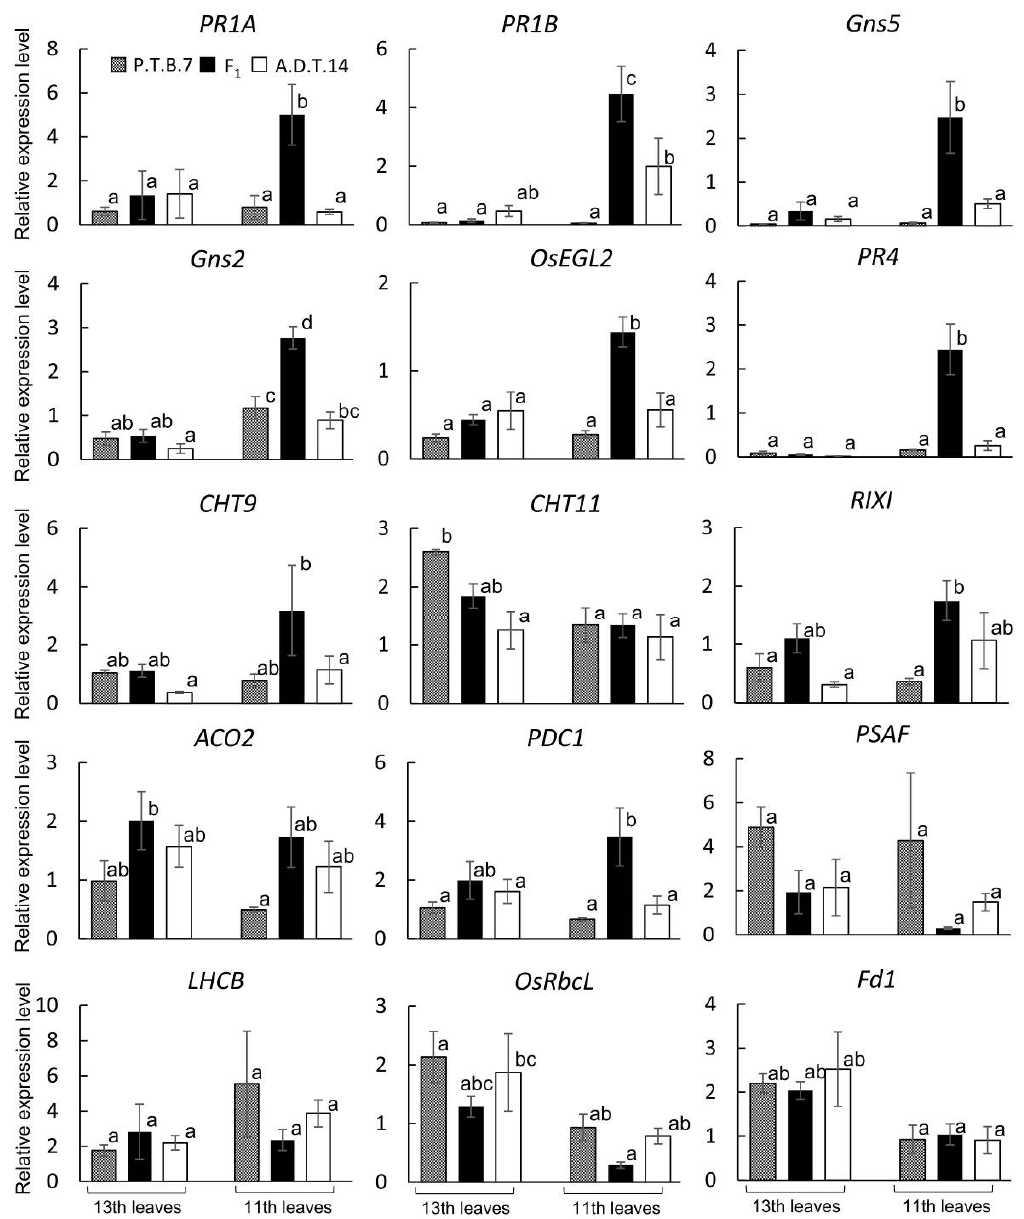
Figure 8. Relative gene expression levels of parental and F 1 hybrid leaves between ‘P.T.B.7′ and ‘A.D.T.14′. Values and error bars indicate mean ± SE values ( n = 3), and different lowercase letters in each plot indicate significant differences (Tukey HSD test, P < 0.05).